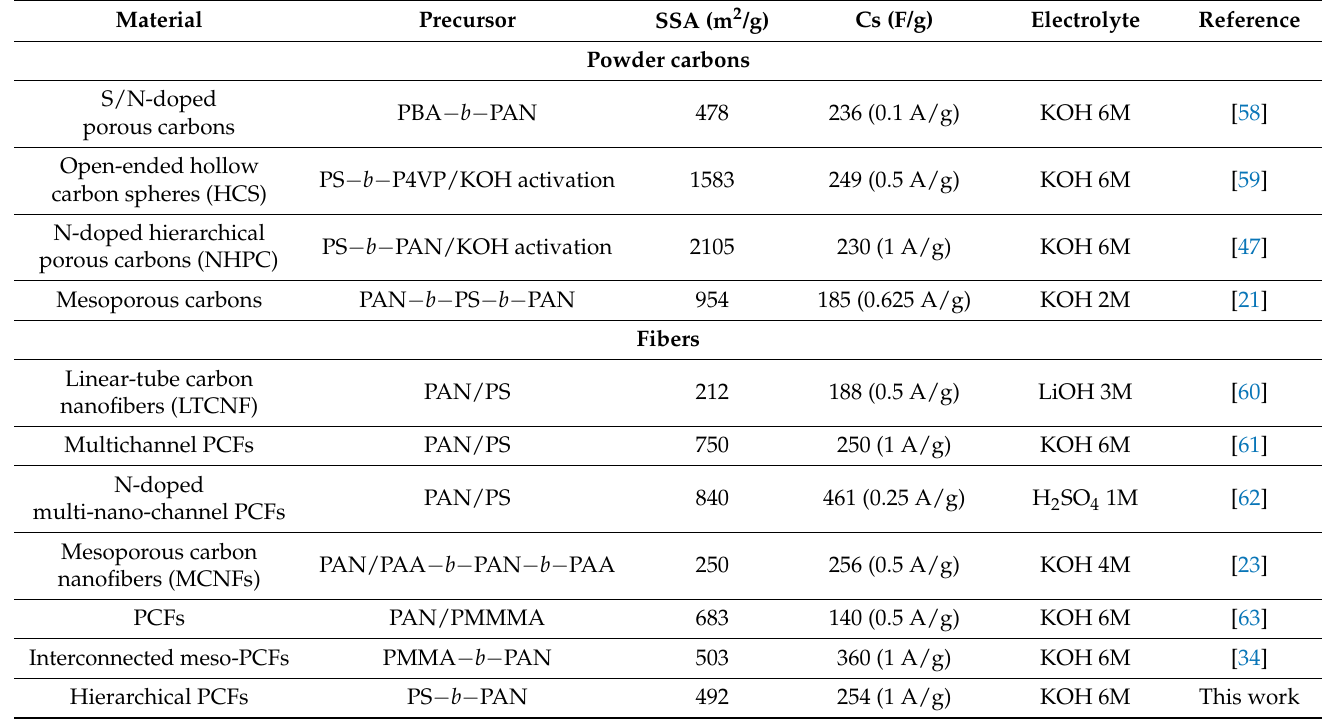
Table 1. Summary of specific surface area and specific capacitance values measured at different current densities (A/g) of various porous carbon fibers (PCFs) and porous carbon powder materials as electrodes for